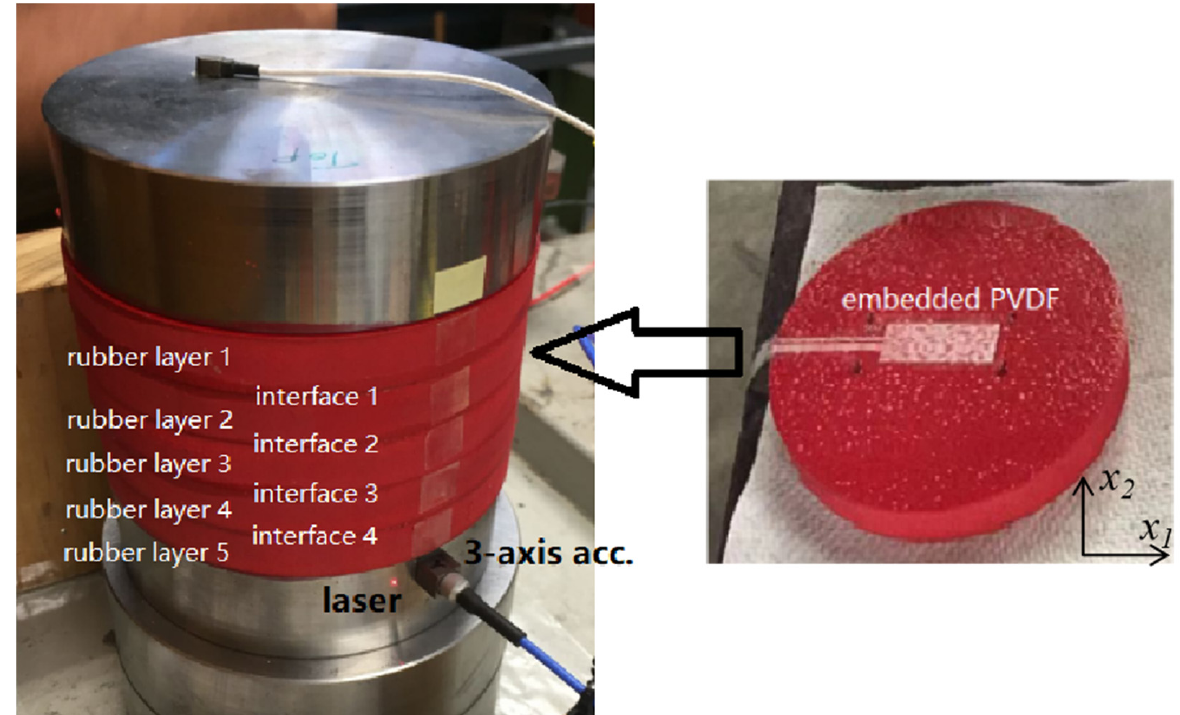
Figure 2. The 5-layer rubber cylinder with embedded longitudinal PVDF array. When the rubber cylinder was excited by the hammer at the center of the top mass block, all the sensors only showed a peak at 87 Hz within the measured frequency range (up to 1600 Hz), which should be corresponding to the natural frequency of the axial mode of the cylinder [13]. Figure 3a displays the response of the PVDF array. The y axis represents the frequency response of the PVDF output voltage with respect to the impact force. Although it might be expected that the magnitude of this peak should decay from the top to the bottom of the cylinder, it was found that PVDF 2 at interface 2 and PVDF 3 at interface 3, which were attached to the middle of the cylinder, had the largest outputs. At 87 Hz, this difference is approximately 1.8 dB (23%). Figure 3b also shows the output distribution of the accelerometer and laser vibrometer at the same frequency. The y axis is the measurement location from the top to the bottom of the cylinder. Acc x, acc y, and acc z represent the radial, vertical, and tangential accelerations measured on the surface of the cylinder by the 3-axis accelerometer, respectively. The laser vibrometer collected the radial velocity on the surface of the cylinder. It is clear that only the vertical acceleration, measured by the y axis of the 3-axis accelerometer, monotonically decreases down the cylinder. All other sensor outputs have a maximum at the middle of the cylinder and minimum at the two ends. Since both the laser vibrometer and x and z axes of the 3-axis accelerometer measured the in-plane vibration for the cylinder, it is necessary to include these contributions when considering the output of embedded PVDF